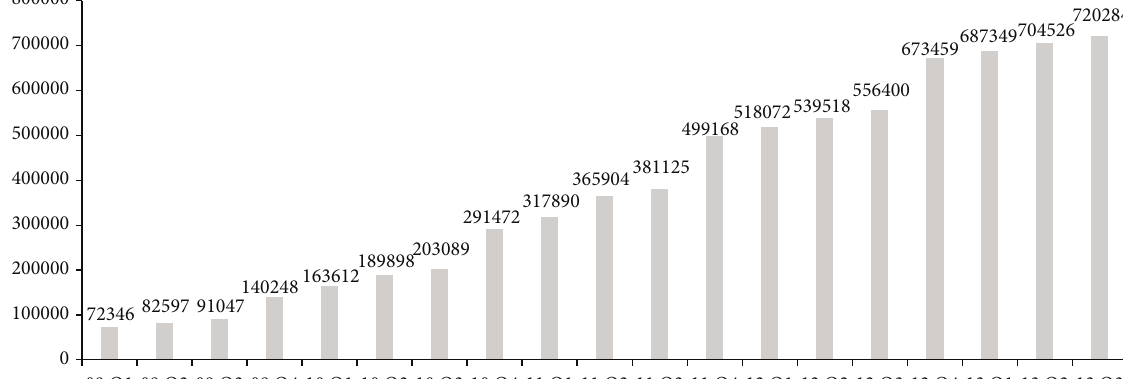
Figure 1: Total amount of external reserves for retirement